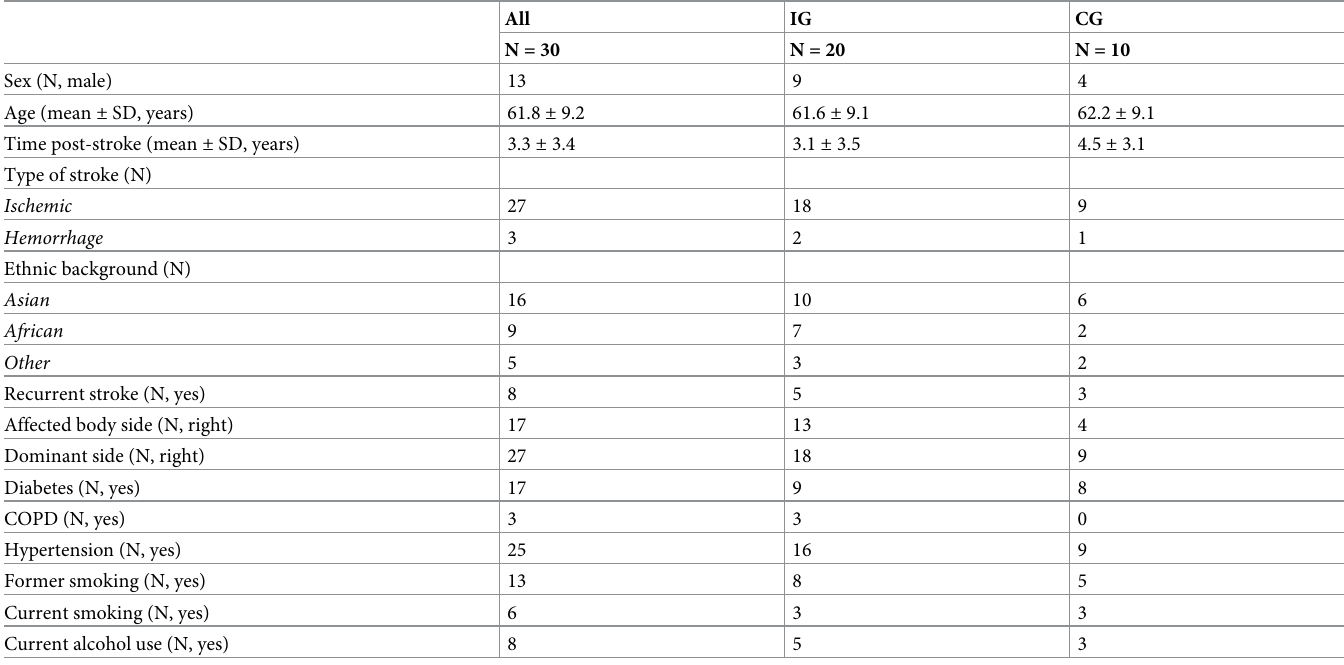
Table 2. Demographic and clinical characteristics of the study